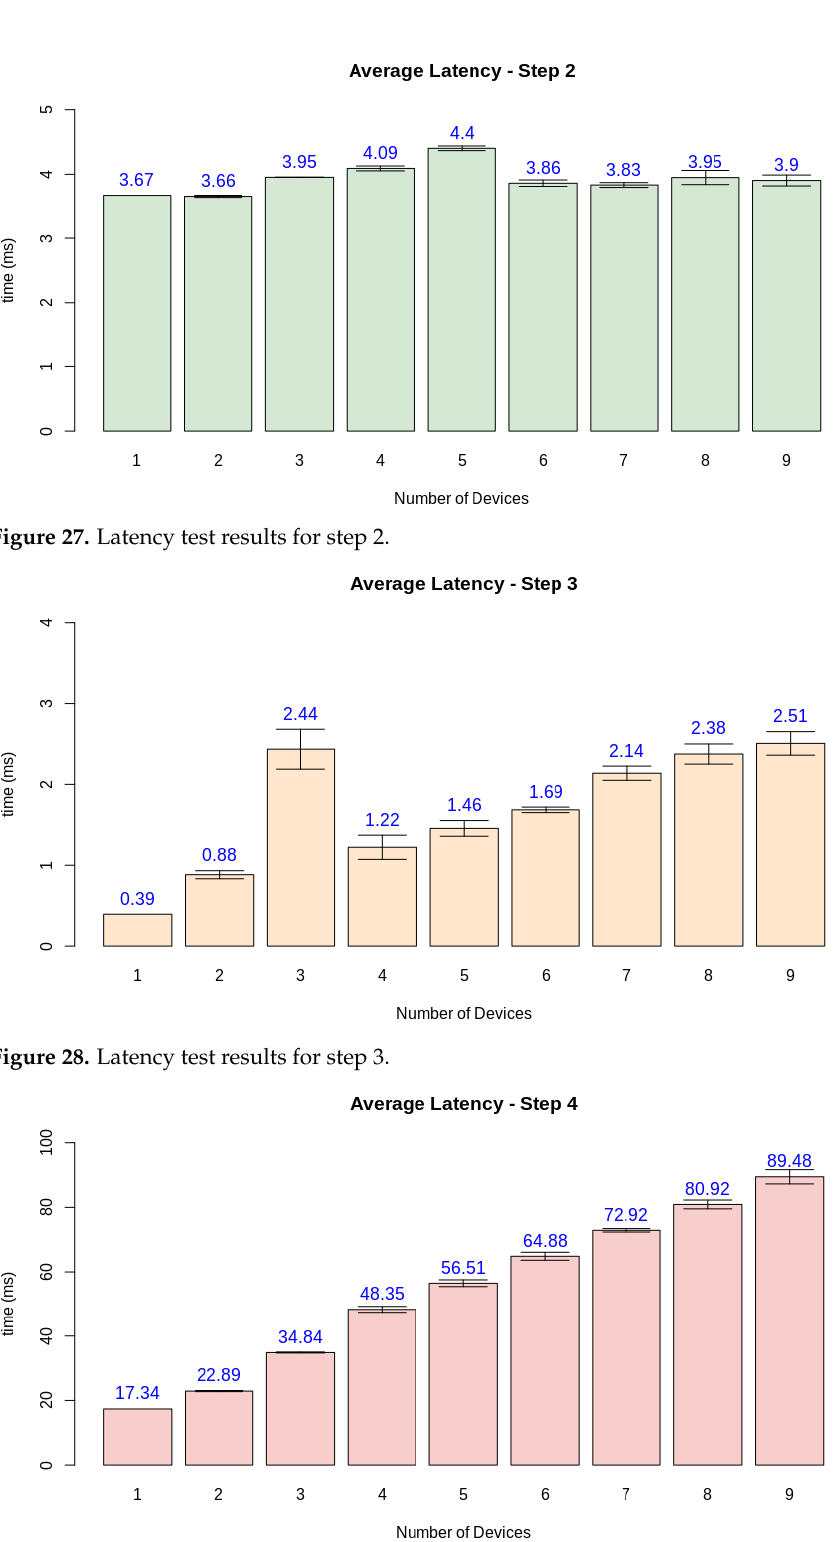
Figure 29. Latency test results for step